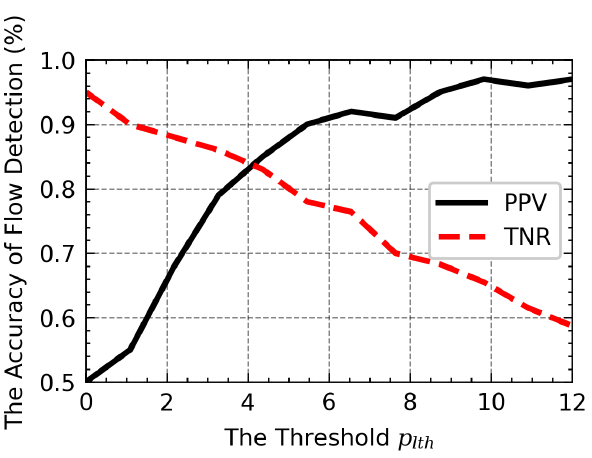
Figure 21. The influence of threshold p lth